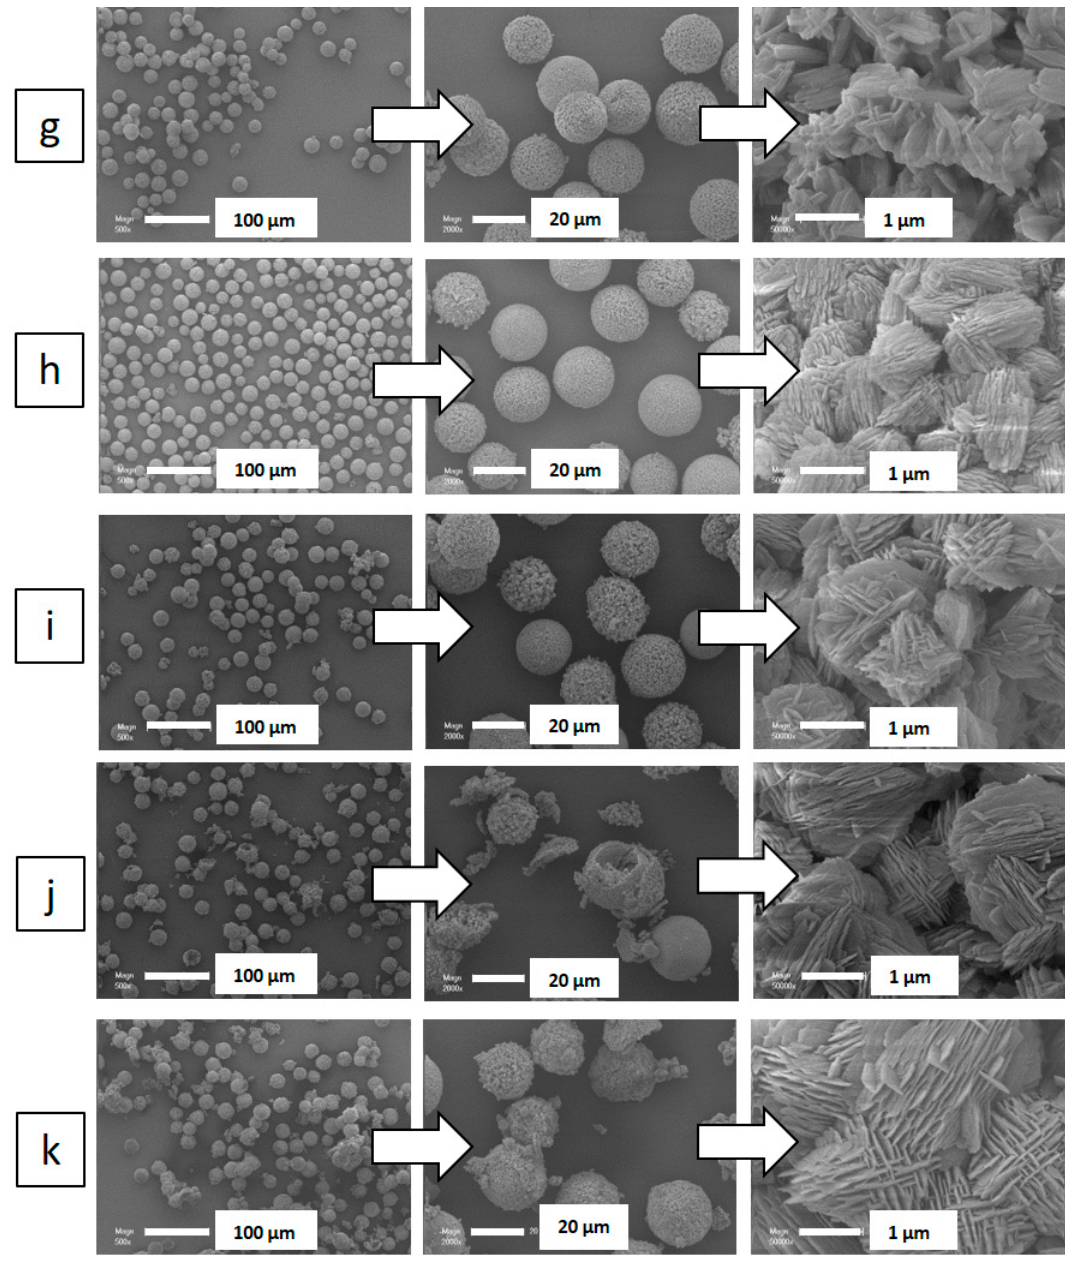
Figure 2. S canning electron microscopy (SEM) images of: ( a ) amorphous 20 μ m silica spheres, and Figure 2. Scanning electron microscopy (SEM) images of: ( a ) amorphous 20 µ m silica spheres, and silicalite ‐ 1 beads as a function of their temperature and duration synthesis (B ‐ T(°C) ‐ t(days)): ( b ) B110 ‐ silicalite-1 beads as a function of their temperature and duration synthesis (B-T( ◦ C)-t(days)): ( b ) B110-2, 2, ( c ) B110 ‐ 3, ( d ) B110 ‐ 5, ( e ) B130 ‐ 2, ( f ) B130 ‐ 3, ( g ) B150 ‐ 1, ( h ) B150 ‐ 2, ( i ) B150 ‐ 3, ( j ) B150 ‐ 4, and ( k ) ( c ) B110-3, ( d ) B110-5, ( e ) B130-2, ( f ) B130-3, ( g ) B150-1, ( h ) B150-2, ( i ) B150-3, ( j ) B150-4, and ( k ) B150 ‐ 5.